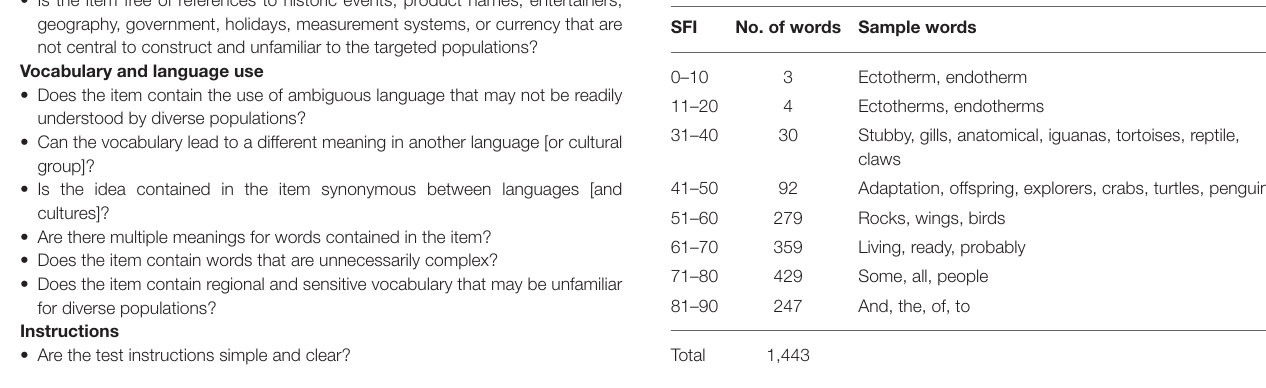
FIGURE 1 | Analysis of familiarity of words in the Green Islands’ task. TABLE 2 | Results of word frequency